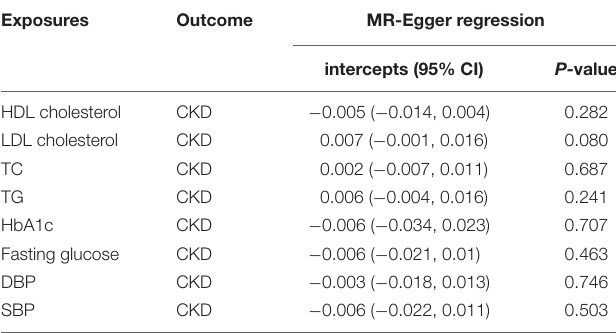
TABLE 1 | Mendelian randomization (MR)-Egger regression